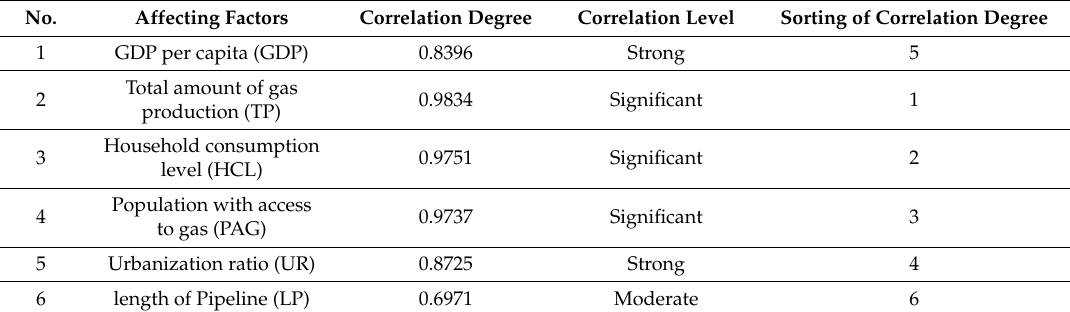
Table 2. Correlation degree between the affecting factors and natural gas consumption.